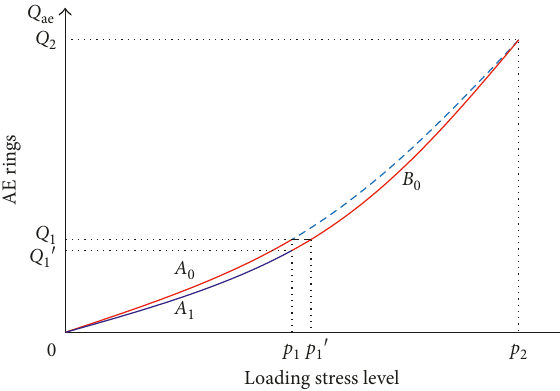
Figure 5: Simplified increasing model of the rock AE